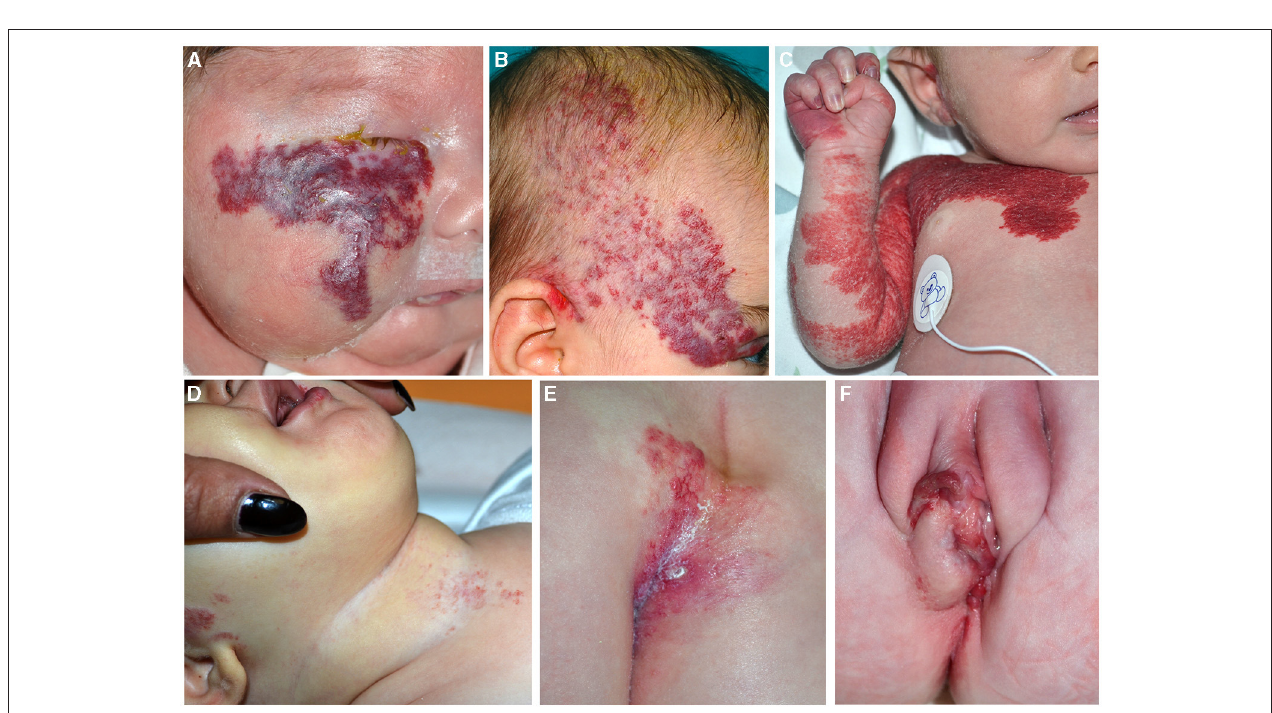
FIGURE 6 | Segmental infantile hemangiomas (IH) of the face (A,B) ; the lesions have a diameter of than 5cm and must be investigated for PHACE syndrome (A) . Segmental IH of the upper part of the trunk and the upper limb in a neonate (C) . Segmental IH is on the beard area in an infant with obstruction of the upper airways (D) . Segmental lumbar and sacral IH associated with myelopathy (E) . IH of the vulva area associated with genital anomalies and imperforate anus (F)